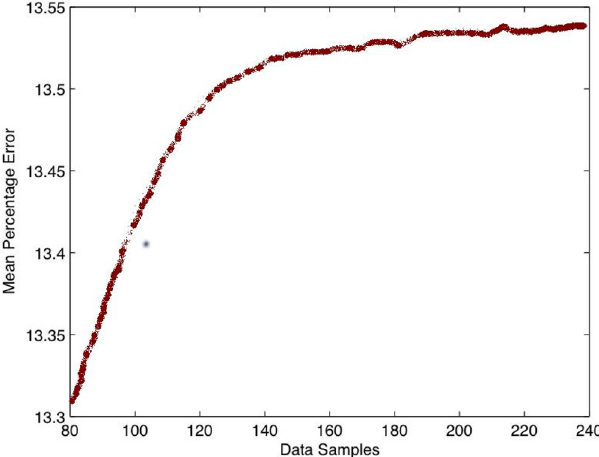
Figure 5. MPE for increasing data sample